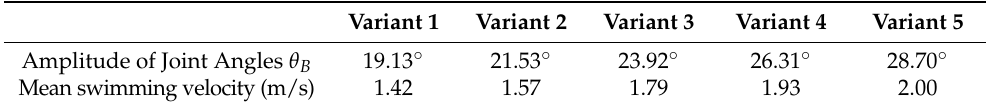
Table 1. Mean swimming velocity of the swimmer under different trunk oscillations.